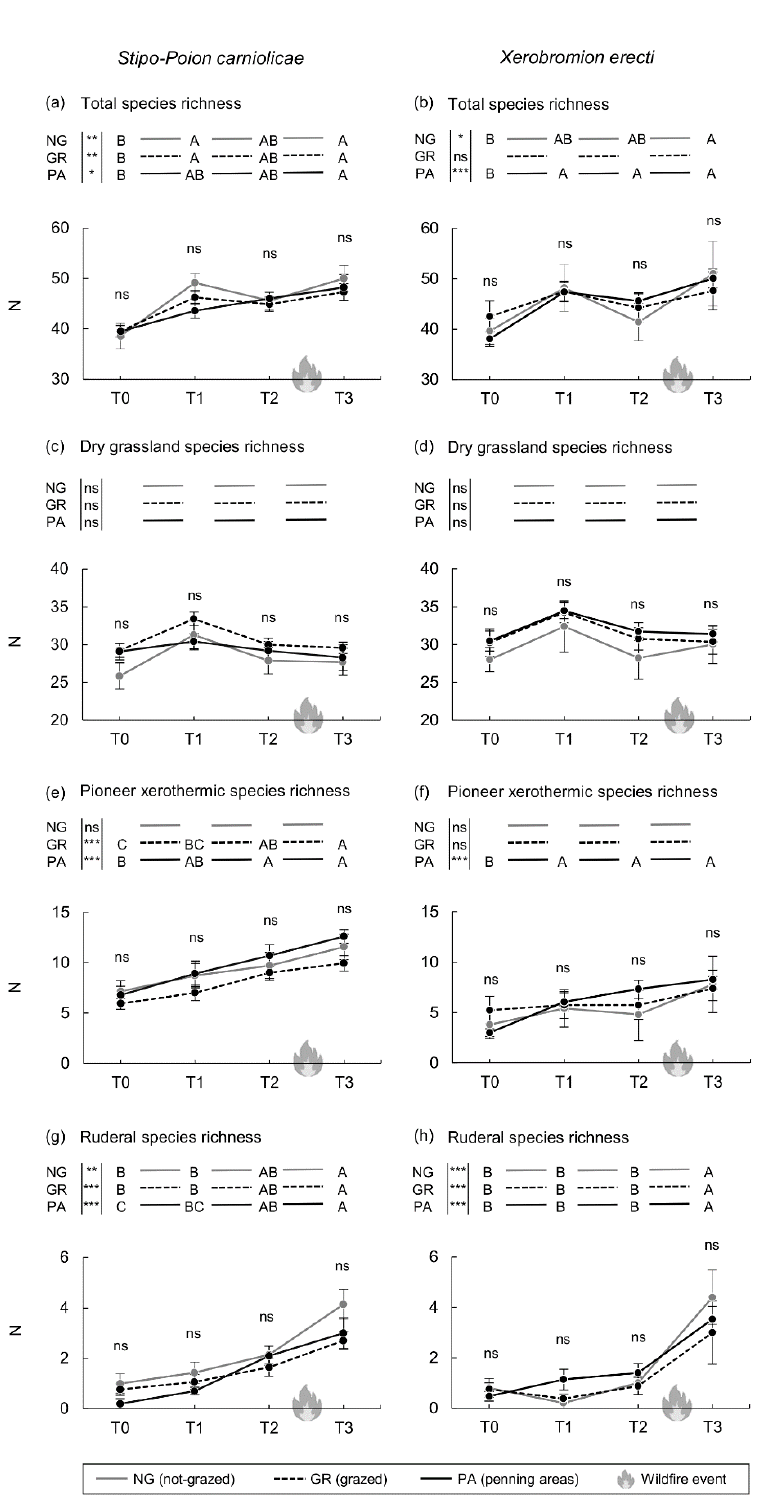
Figure 3. Results of the generalized linear mixed models performed on total species richness ( a , b ) and richness of dry grassland species ( c , d ), pioneer xerothermic species ( e , f ) and ruderal species ( g , h ) in Stipo-Poion carniolicae and Xerobromion erecti grassland types. Uppercase letters indicate significant differences among years within each treatment according to Tukey’s post hoc tests. Years: T0, before grazing implementation; T1 and T2, after one and two years of grazing; T3, after the wildfire. Significance levels: ns, p ≥ 0.05; *, p < 0.05; **, p < 0.01; ***, p < 0.001.